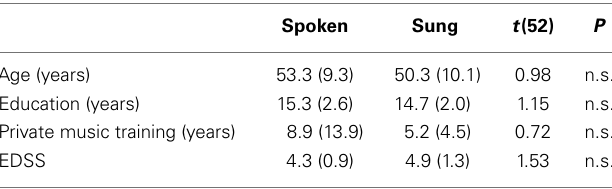
Table 1 | Demographic data of MS participants: means (standard deviations)